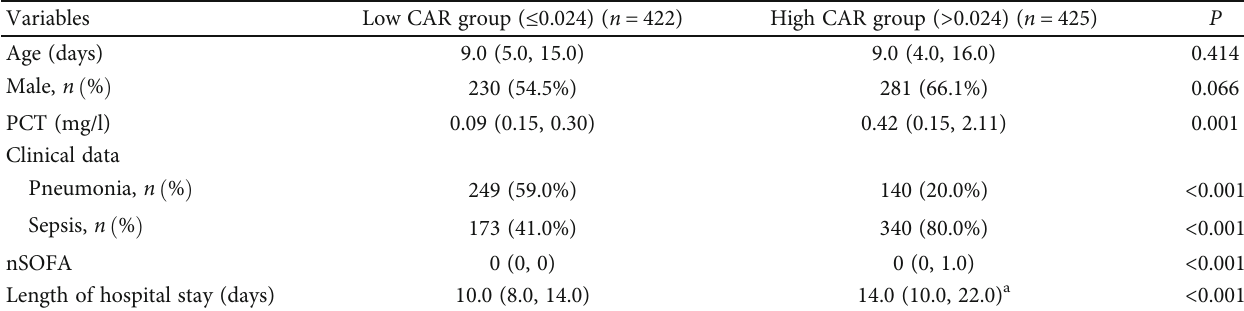
Table 2: Clinical and demographic characteristics according to the median of CAR.